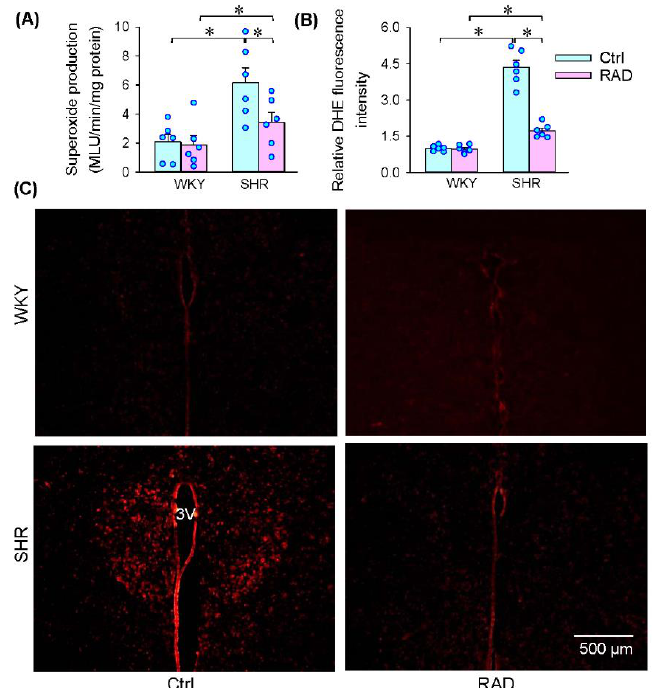
Figure 4. Effects of RAD on superoxide production in the PVN of WKY and SHR. ( A ) Superoxide production. ( B ) Bar graphs showing relative DHE fluorescence intensity. ( C ) Representative images showing DHE fluorescence staining in the PVN areas. 3 V, the third ventricle. Values are mean ± SE. Two- way ANOVA followed by Bonferroni’s post hoc analysis were used for comparisons. * p < 0.05. n = 6 for each group.